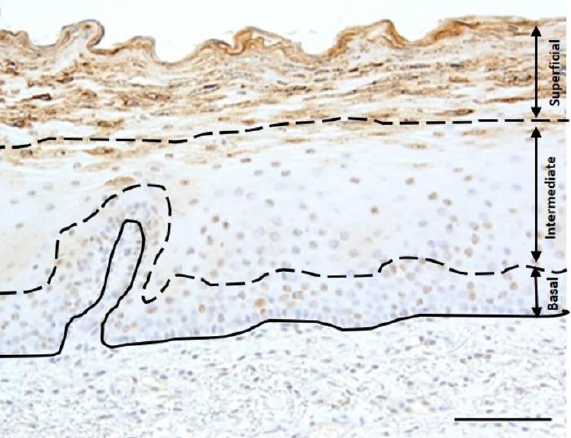
Figure 1. The scoring of the staining intensity and the immune localization of MUC1, CD44, and HA in the epithelium was evaluated in the basal cell layer, intermediate cell layer, and superficial cell layer under a light microscope (Bar = 100 µm).